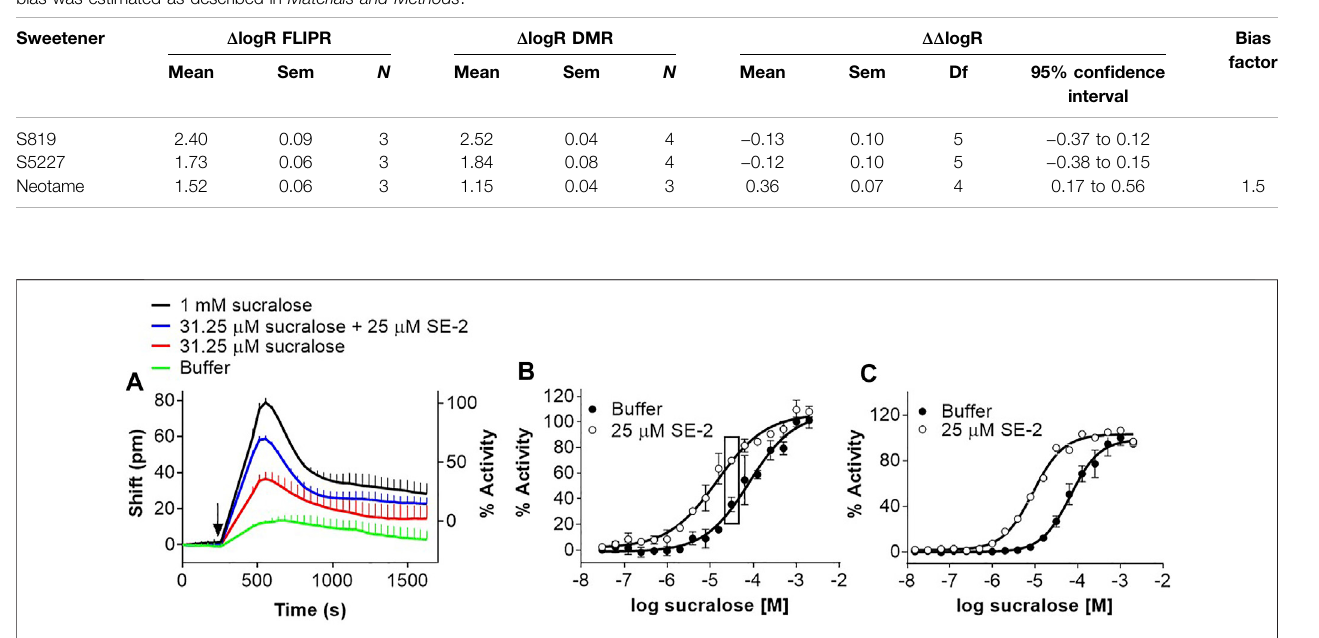
FIGURE 8 | Evaluation of a PAM for the human sweet taste receptor in the DMR and FLIPR assays. (A) R2/R3 U2OS cells were stimulated with increasing concentrations of sucralose in the presence and absence of 25 μ M SE-2 and DMR responses were monitored on the Epic ® reader. Depicted are the kinetics correspondingtotheeffectofSE-2on31.25 μ Msucralose. (B) Depictionofthefullsucralosedose-responseanalysisoftheexperiment describedin (A) .Therectangles include datapoints from which the kinetics inPanel Awere taken. (C) R2/R3 U2OS cells were transduced withG α 15 baculovirus. After48 hours, cellswereloaded withFluo4andstimulated withincreasingconcentrationsofsucraloseinthepresenceandabsenceof25 μ MSE-2andresponsesweremonitoredontheFLIPR.Curves are representative of three independent experiments and data points correspond to an average and standard deviation of a triplicate